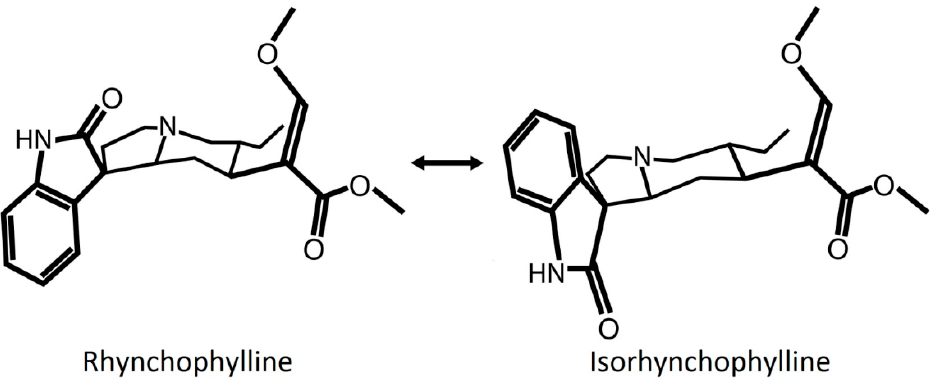
Figure 1. Representation of the chemical structure of Rhynchophylline (Rhy) and Isorhynchophylline (Isorhy). The position of the oxindole structure (N-C=O in the second ring) of the alkaloids Rhy and Isorhy is different. Both molecules are diastereoisomers, interconvertible with each other depending on pH and temperature. Temperature is suggested to induce a break and reclosure of the third ring that results in a twisted conformation [14].